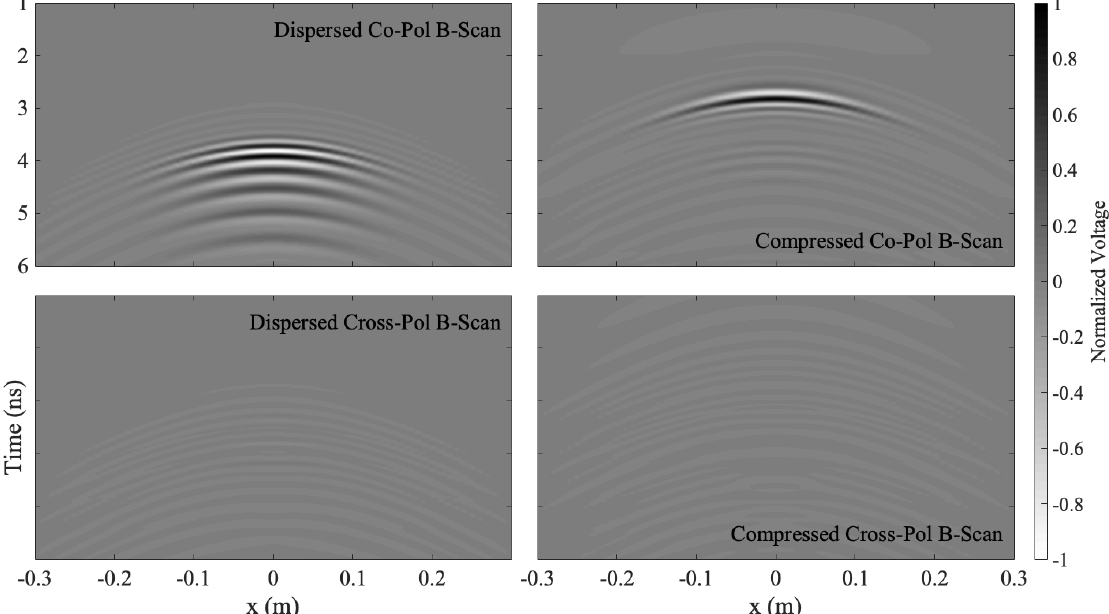
Figure 13. GPR simulation results: dispersed co-pol and cross-pol B-scans ( left ) and corrected B-scans using an optimized dispersion model ( right ) for a small linear target aligned with the incident wave